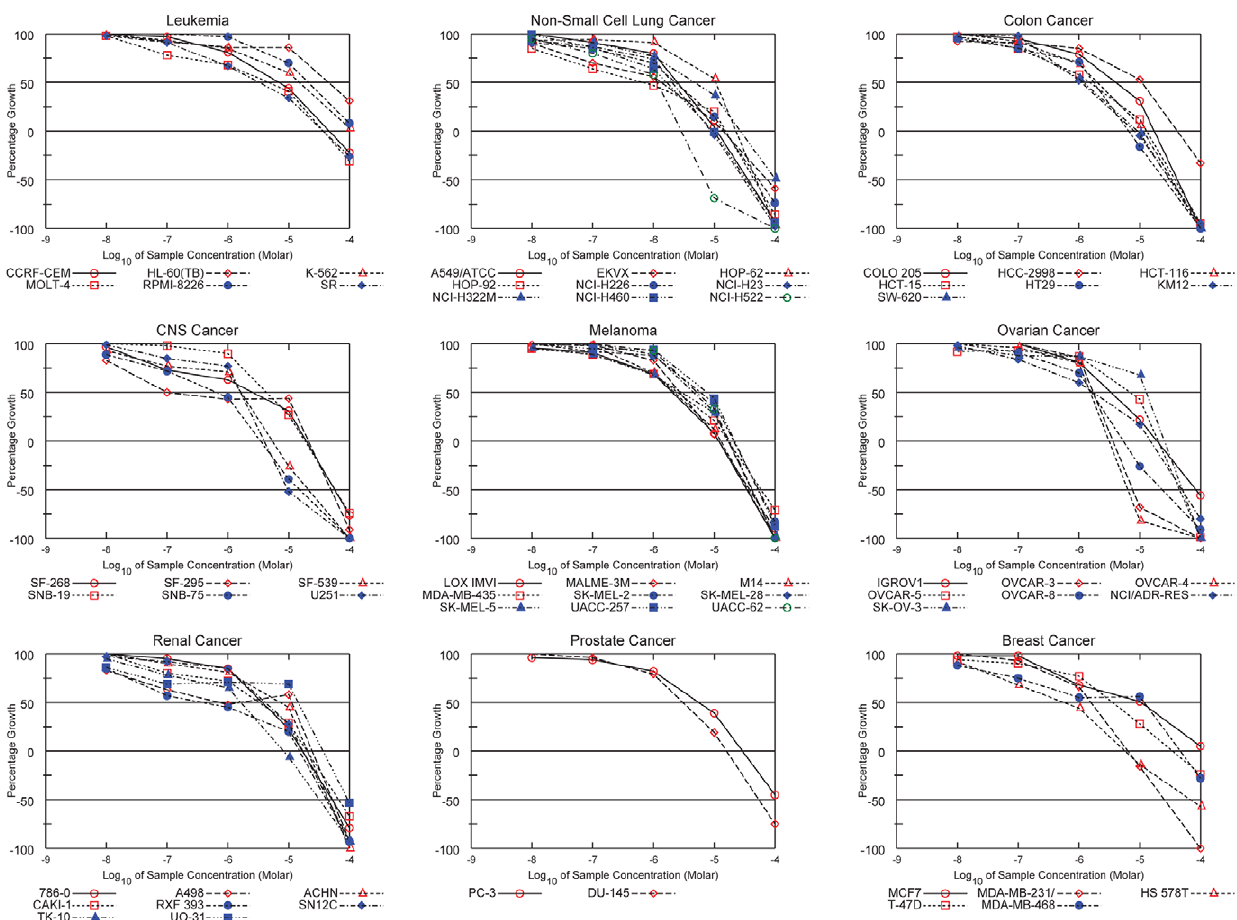
Figure 9. Cytotoxic effects of Triflorcas on the NCI60 panel of cancer cell lines. The cytotoxic effects of Triflorcas (10, 100 nM, 1, 10, 100 m M) was determined by sulphorhodamineB assay after 48 hours of drug treatment. Results shown are representative of two independent experiments.